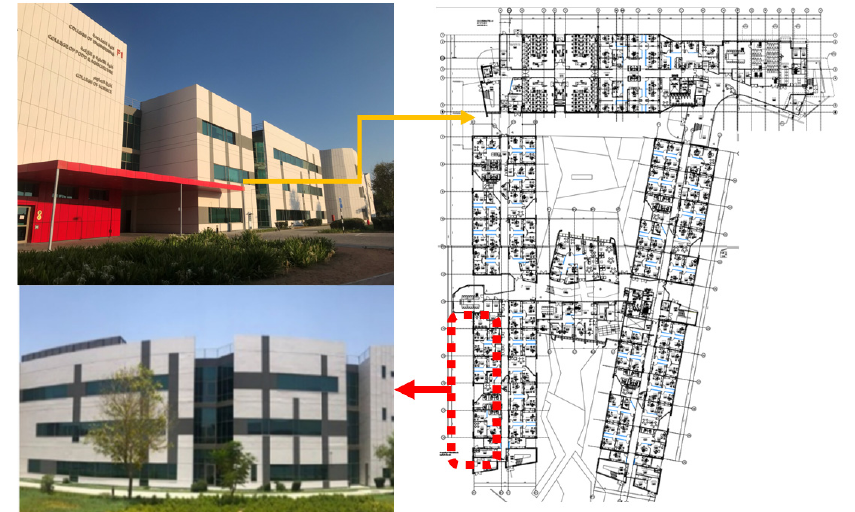
Figure 2. Case study building typical floor plan and exterior photos (west-facing selected block indicated in red).